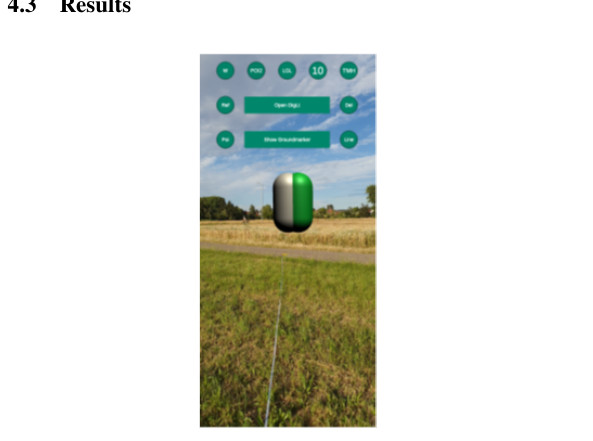
Figure 7. Optical impression of a measurement Figure 7 gives an optical impression of a measurement where the standard deviation of the compass was 4.8°. The gray and green capsules are almost exactly on top of each other, the error of the compass in this single shot is nearly 0°.